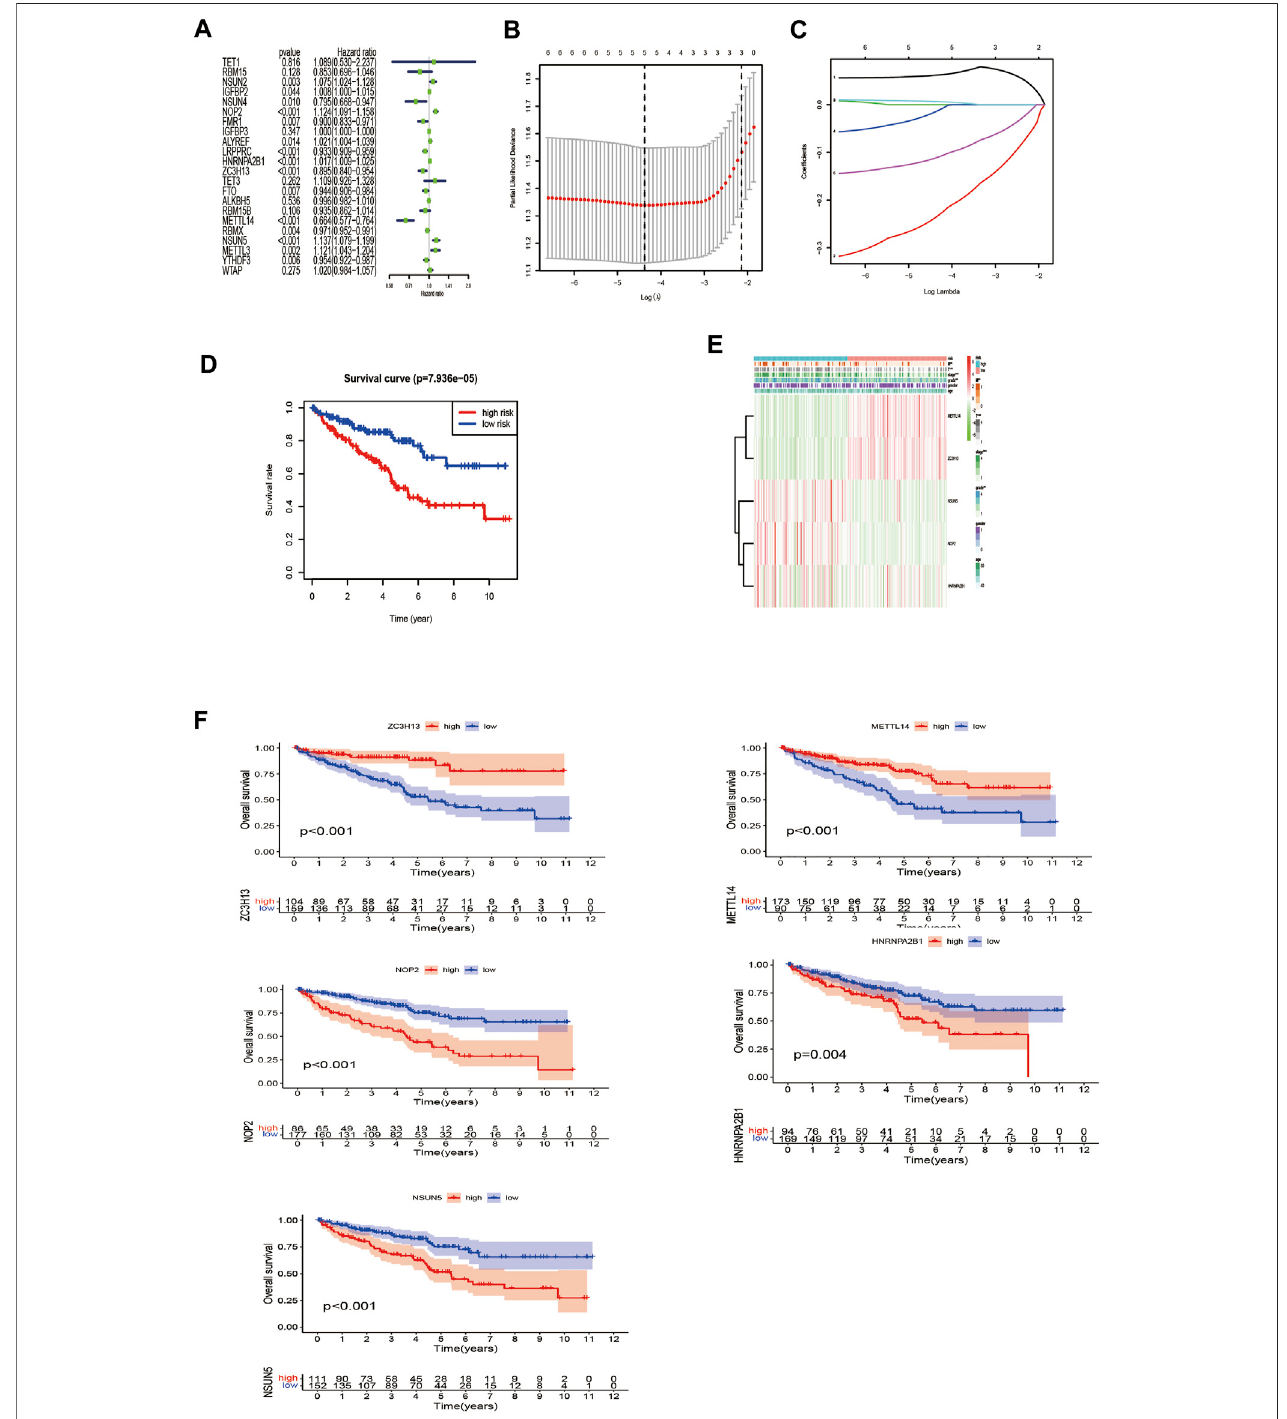
FIGURE3 | Construction ofthe risksignature according tothe m6Aand m5CRNA methylation regulators. (A) Forest plotof theunivariate Coxregression analysis for the 22 regulators. Identi fi cation of six signi fi cant regulators (* p < 0.05, ** p < 0.01, and *** p < 0.001). (B,C) LASSO coef fi cient pro fi les of the six regulators. Cross- validation for tuning parameter selection in the LASSO model. (D) The K – M analysis showed that patients in the low-risk group presented better OS than those in the high-riskgroup.Thisanalysiswasbasedonthesurvivalinformationofsamplesinthetrainingset.Theredlinerepresentsthehigh-riskcluster,whereastheblueline indicatesthelow-riskcluster. (E) Thetrainingsetoftheheatmapoftherelationshipbetweenthegeneexpressionofthecorresponding fi veregulatoryfactorsandclinical features. * p < 0.05, ** p < 0.01, and *** p < 0.001. (F) Kaplan – Meier survival curves for OS of fi ve regulatory factors.